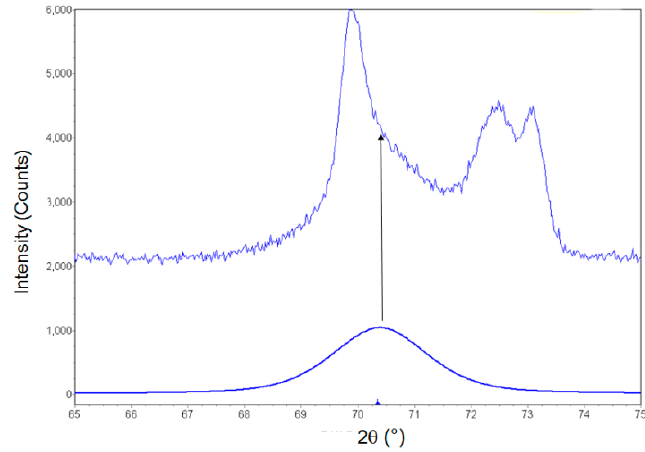
Figure 3. Comparison of the measured and predicted (bottom smooth curve) XRD patterns for the Group 4 precipitates for the (220) plane.